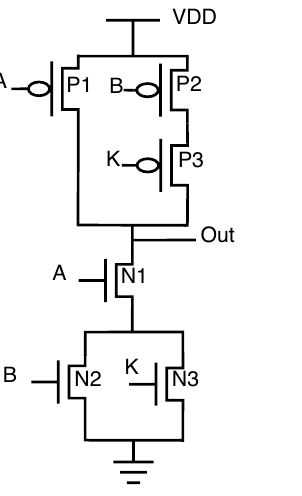
Figure 12. Secure